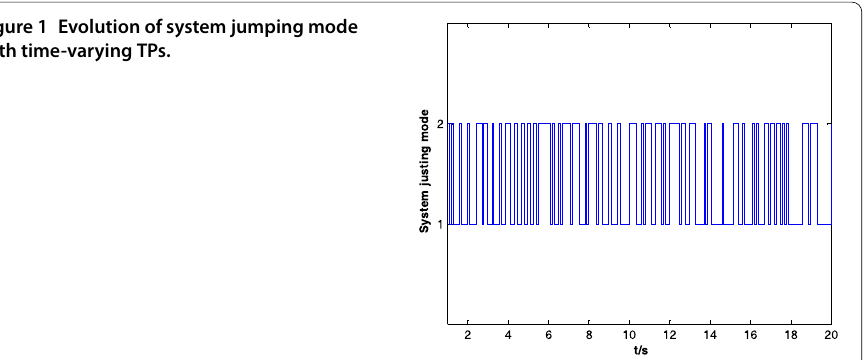
Figure 1 Evolution of system jumping mode with time-varying